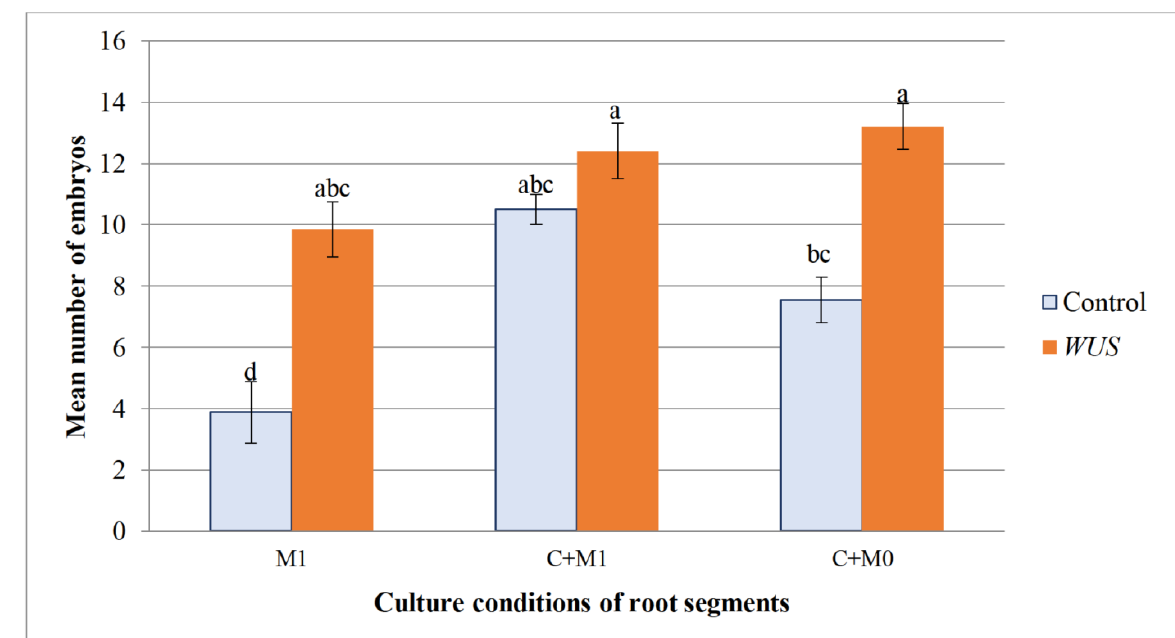
letters were significantly different at p < 0.05.